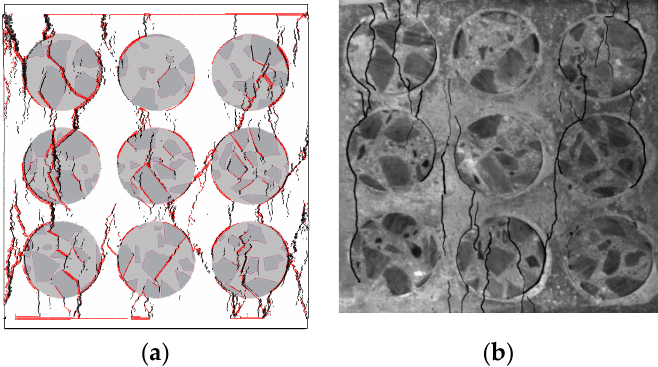
Figure 18. Crack distribution at stage e (post-peak loading stage): ( a ) numerical results;